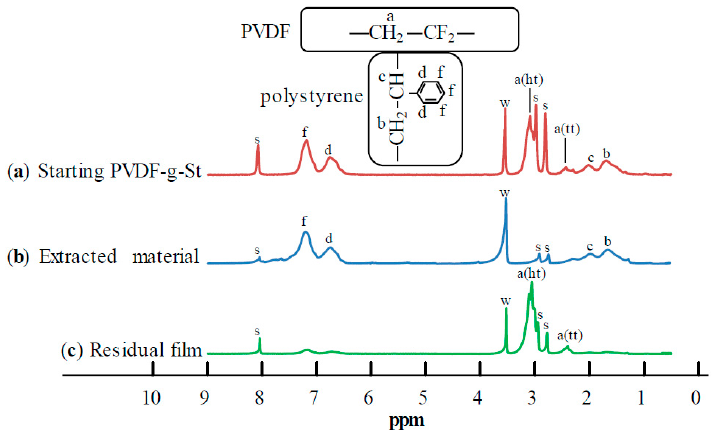
Figure 3. 1 H NMR of ( a ) starting PVDF– g –St film; ( b ) extracted material; and ( c ) 72 h-extracted residual film.